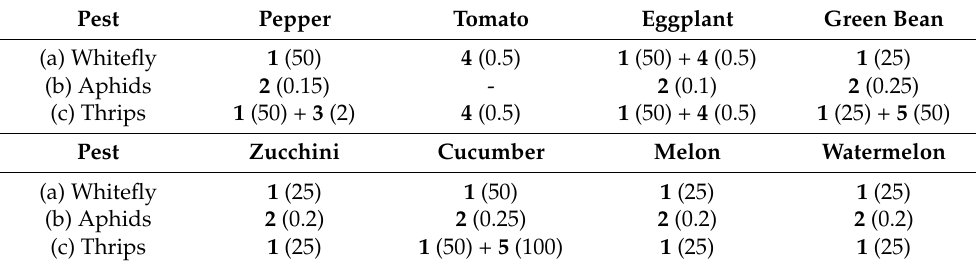
Table 3. Pests to be controlled and minimum doses of BCO releases (no. BCOs/m 2 ) for each crop. Pest Pepper Tomato Eggplant Green